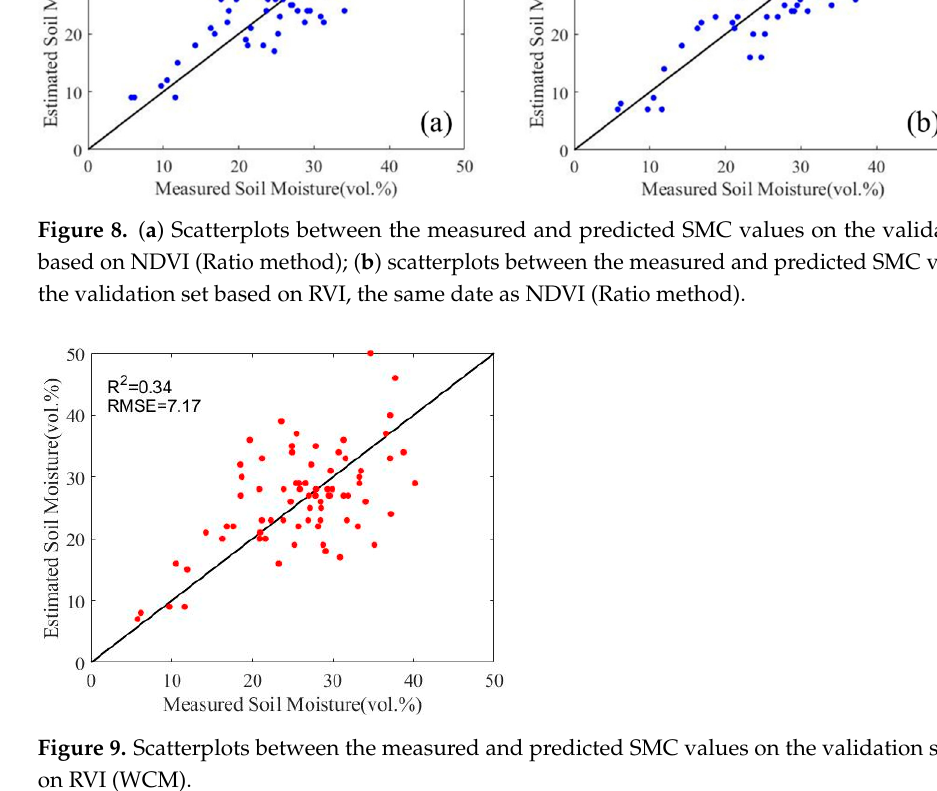
Figure 10. ( a ) Scatterplots between the measured and predicted SMC values on the validation set based on LAI (WCM); ( b ) scatterplots between the measured and predicted SMC values on the val ‐ idation set based on RVI, the same date as LAI (WCM). Figure 11. ( a ) Scatterplots between the measured and predicted SMC values on the validation set based on NDVI (WCM); ( b ) scatterplots between the measured and predicted SMC values on the validation set based on RVI, the same date as NDVI (WCM).